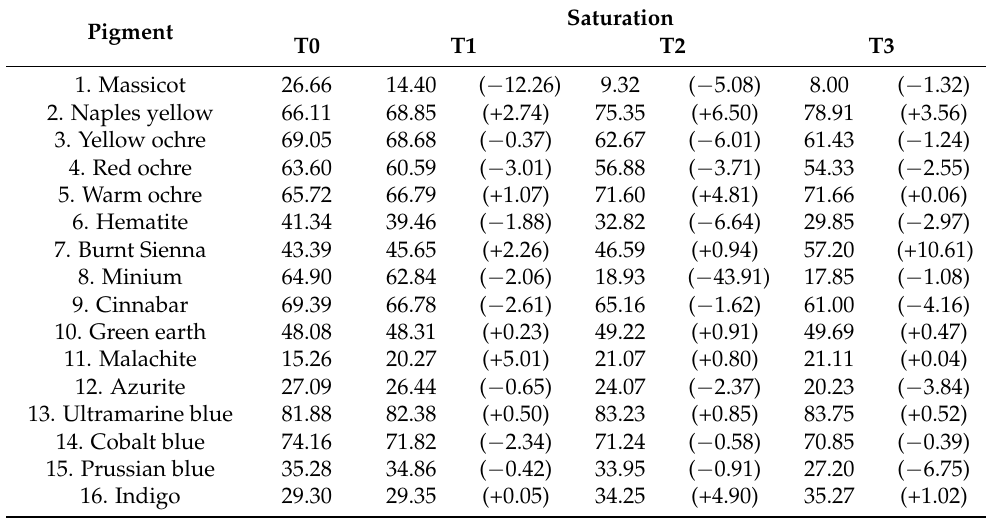
Table 3. Quantification of saturation at different aging steps for the fundamental pigments of Section 1.1. Values in parentheses denote the difference compared to the previous aging